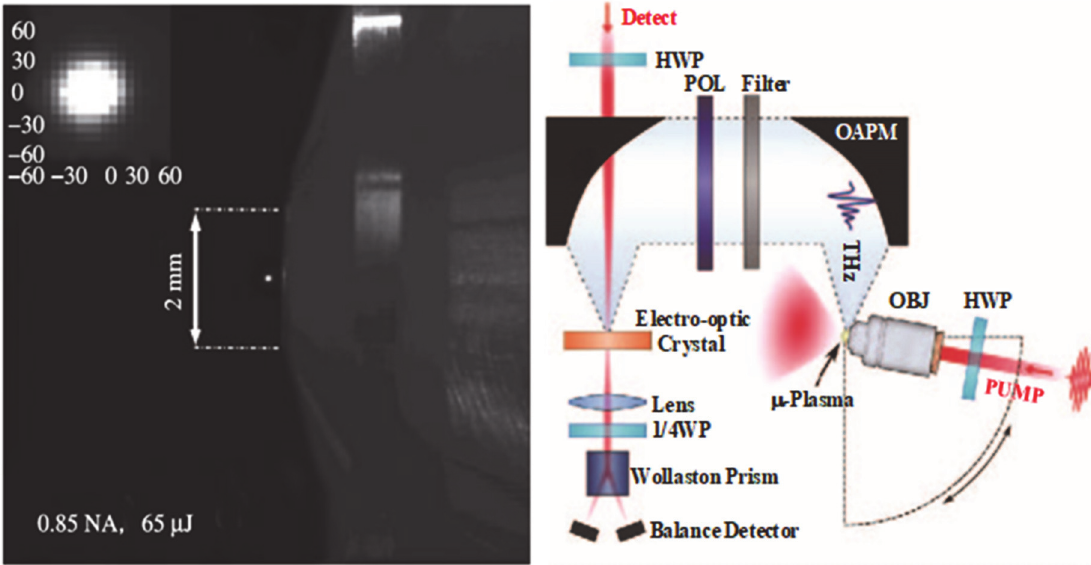
Figure 4. Schematic diagram of laser-induced plasma generation and detection of terahertz waves [30]. In the “two-color” method, the femtosecond laser-induced microplasma has a greater degree of freedom for THz radiation regulation than the “one-color” method. Thiele et